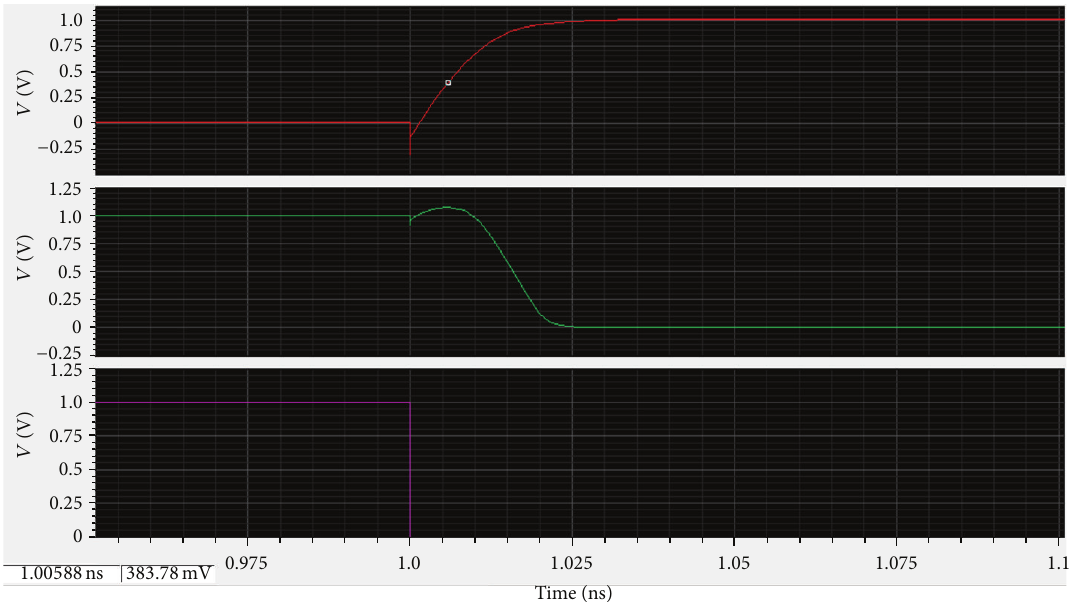
Figure 11: Skew reduction block output-transition from high to